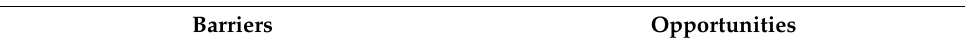
Table 1. Summary of participants’ perceptions of barriers and opportunities for the adoption of gender-sensitive strategies in the Westerns Highlands of Guatemala. Adoption of Gender-Sensitive CSA Strategies in the Western Highlands of Guatemala Barriers